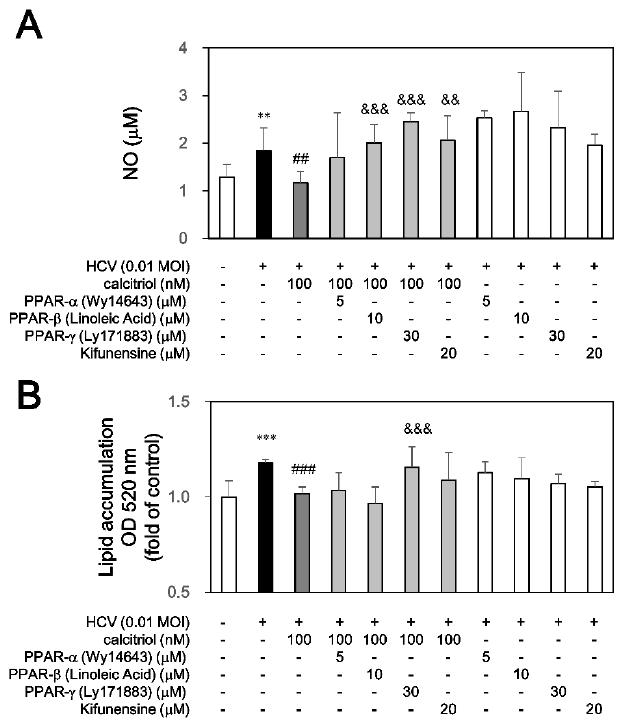
Figure 4. Effects of calcitriol on NO release and lipid accumulation in HCV infection. ( A ) HCV- infected Huh7.5-SEAP cells (2 × 10 4 ) were pretreated with 5 μ M of Wy14643, 10 μ M of linoleic